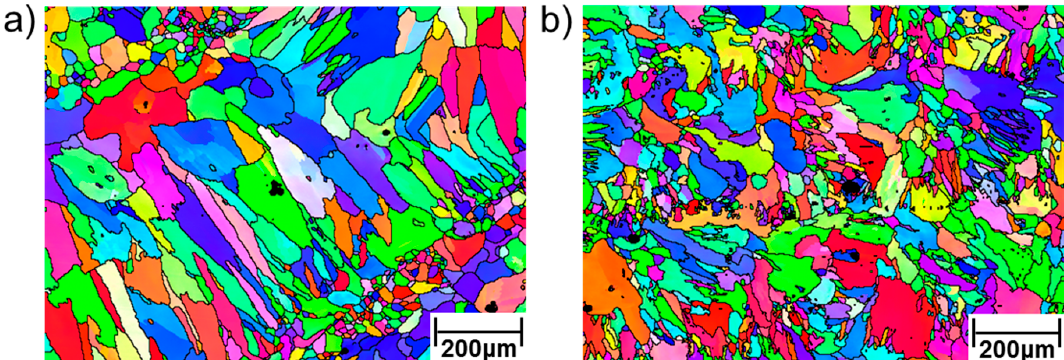
Figure 24. EBSD micrographs (IPFs) of LMD-processed HiperFer AM : ( a ) 3 mm of beam diameter, showing rod-shaped grains (in the center region), adjacent to equi-axed grains and fine grain formation in re-molten regions; ( b ) 0.66 mm beam diameter, depicting less and thinner rod-shaped grains in the center and generally smaller grain size.